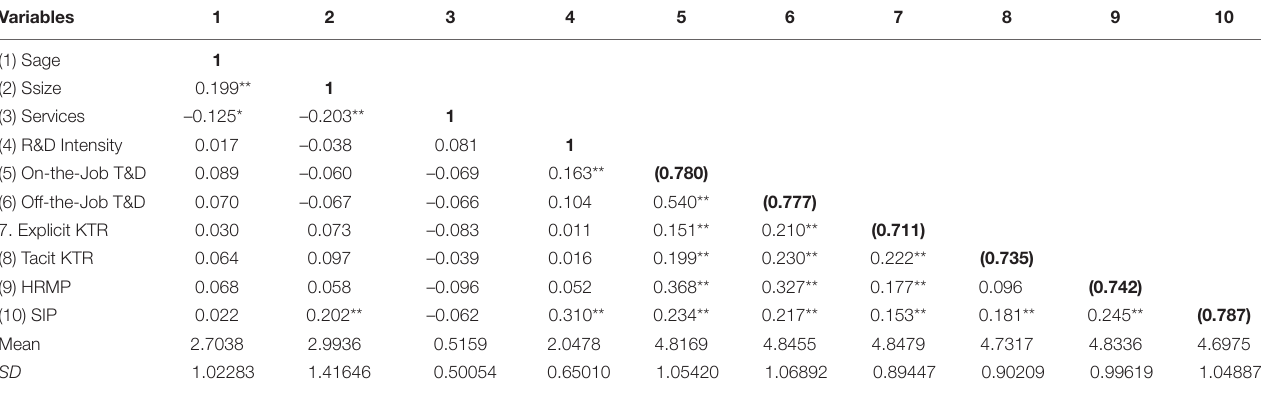
TABLE 2 | Descriptive statistics, Pearson intercorrelations, and discriminant validity.